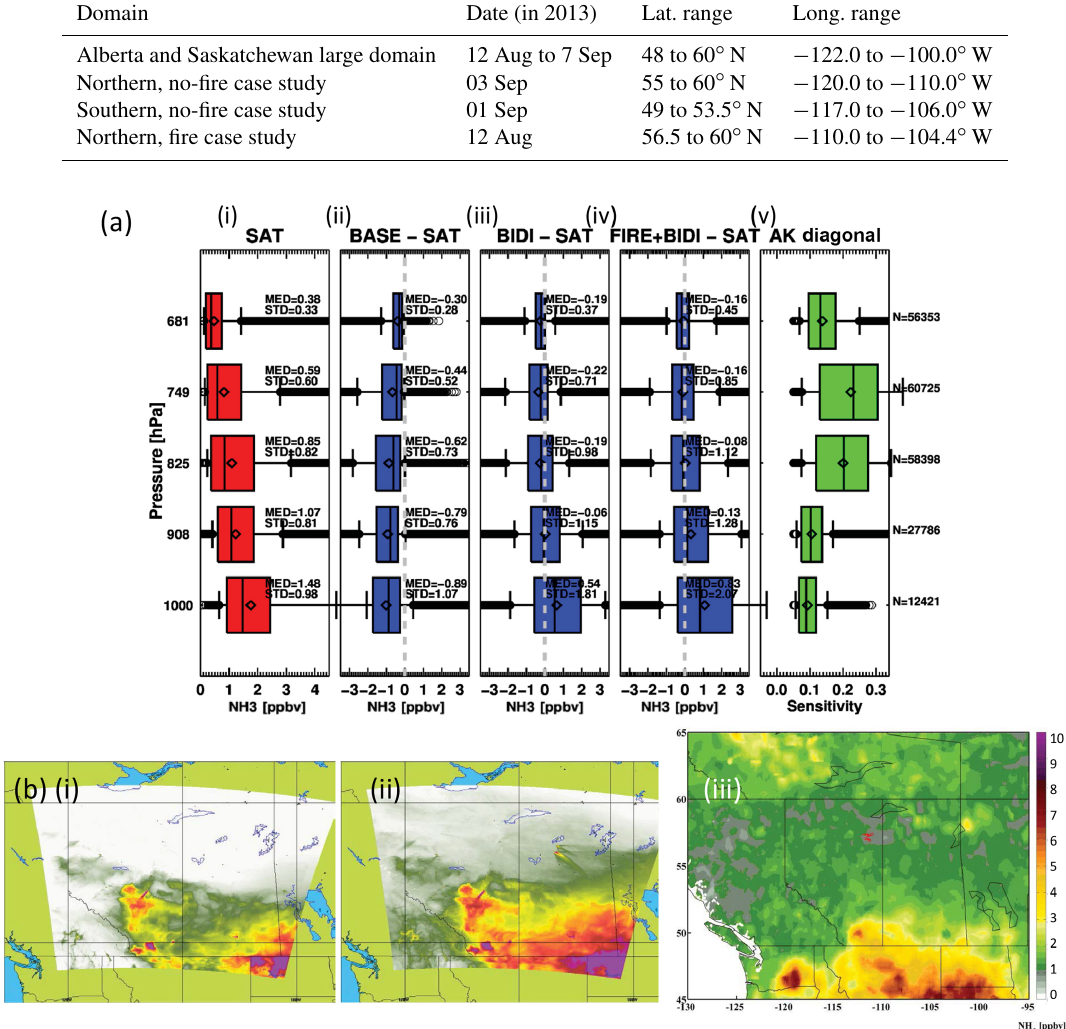
Figure 9. (a) (i) NH 3 vertical profiles as measured by CrIS satellite from 12 August to 7 September 2013; difference between measurement and (ii) base model, (iii) bidi model, and (iv) fire + bidi model; and (v) averaging kernel (labelled AK) of CrIS satellite for NH 3 retrieval. (b) Average (12 August–7 September 2013) surface NH 3 VMRs given by the (i) base model, (ii) fire + bidi model, and (iii) CrIS